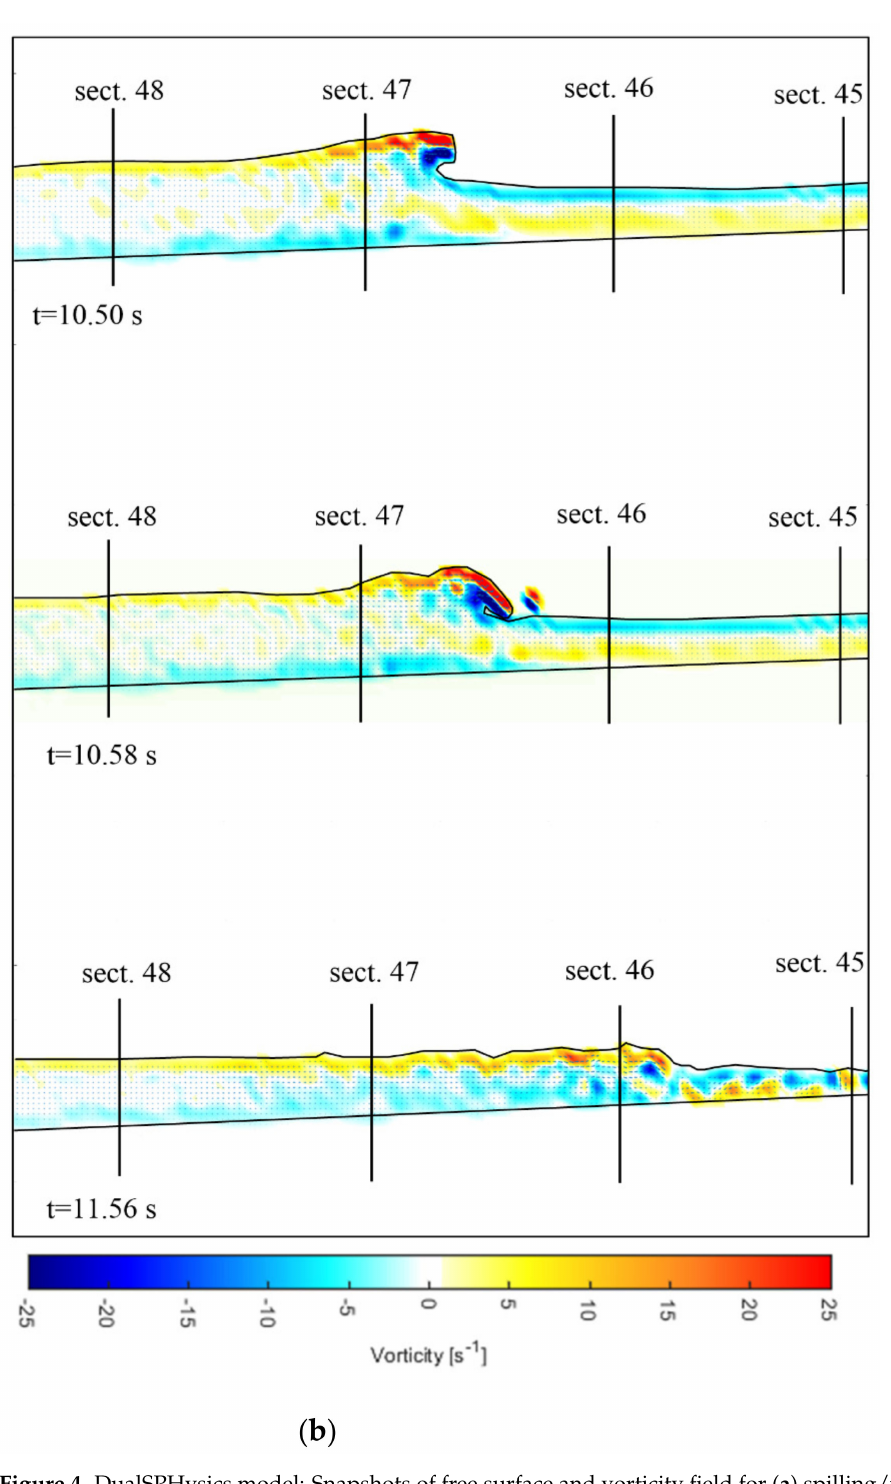
Figure 4. DualSPHysics model: Snapshots of free surface and vorticity field for ( a ) spilling/plunging breaking wave (T1) and ( b ) plunging breaking wave